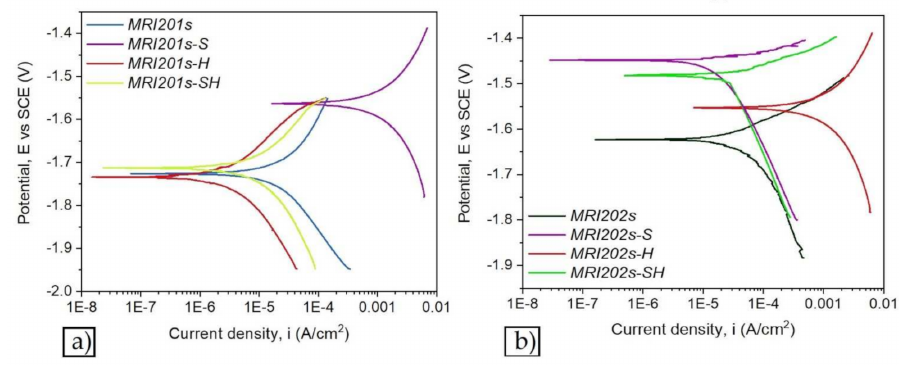
Figure 8. The Tafel plots of magnesium alloys: MRI201s alloy ( a ), MRI202s alloy ( b ). Based on Tafel extrapolation the main electrochemical parameters were extracted: open circuit potential (E OC ); corrosion potential (E corr ); corrosion current density (i corr ); cathodic Tafel slope ( β c ); anodic Tafel slope ( β a ). In the Table 4 are presented the main electrochemical parameters of corrosion processes. Table 4. Main obtained electrochemical